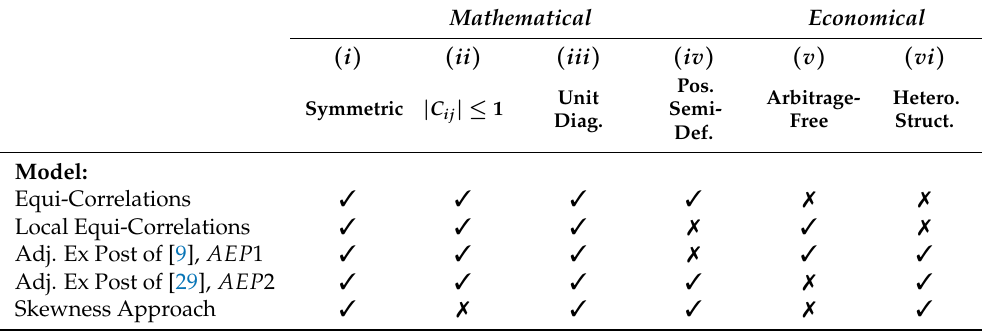
Table 1. The evaluation of existing models with respect to the developed requirements for realistic implied correlation matrices. A check mark (cid:51) indicates that the model is compliant with the condition. If it does not guarantee to comply, then it is marked with a (cid:55) . A realistic solution has to fulfill all constraints (i)–(vi). Mathematical Economical ( i ) ( ii ) ( iii ) ( iv ) ( vi ) Pos. Unit Arbitrage- Hetero. Symmetric | C ij | ≤ 1 Semi- Diag. Free Def.